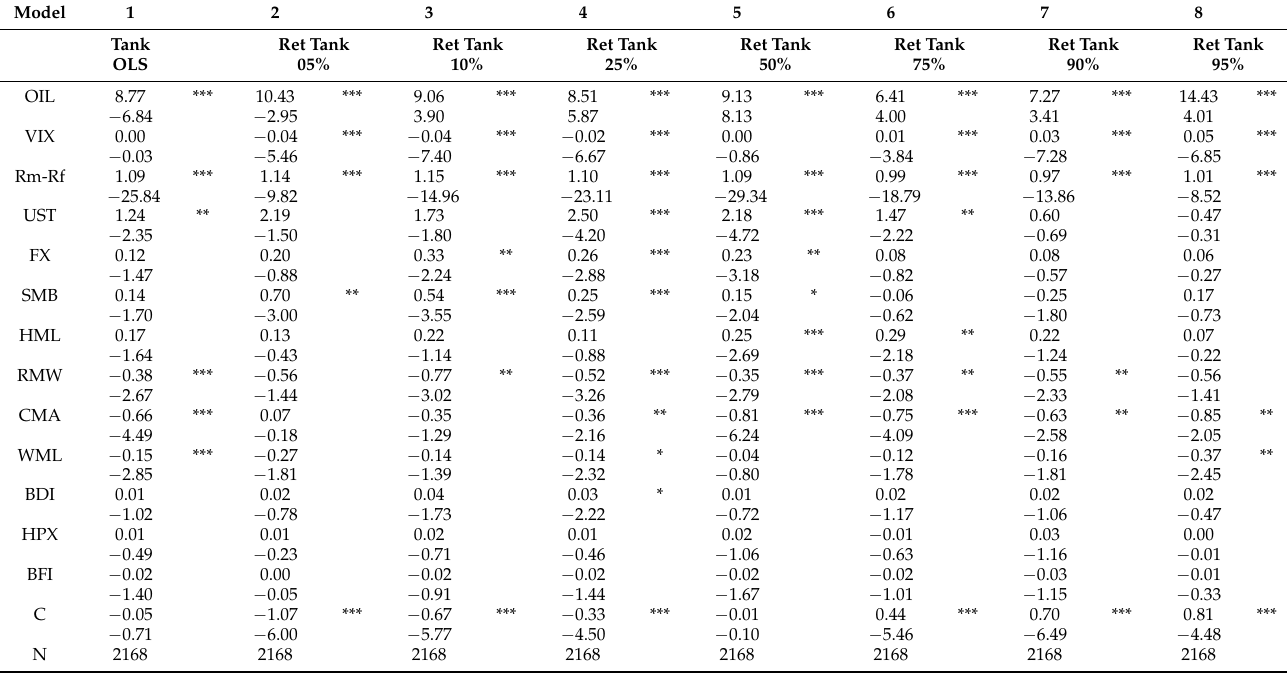
Table 13. OLS and quantile regression estimates Tanker shipping firms Second Subperiod (2009–2016).